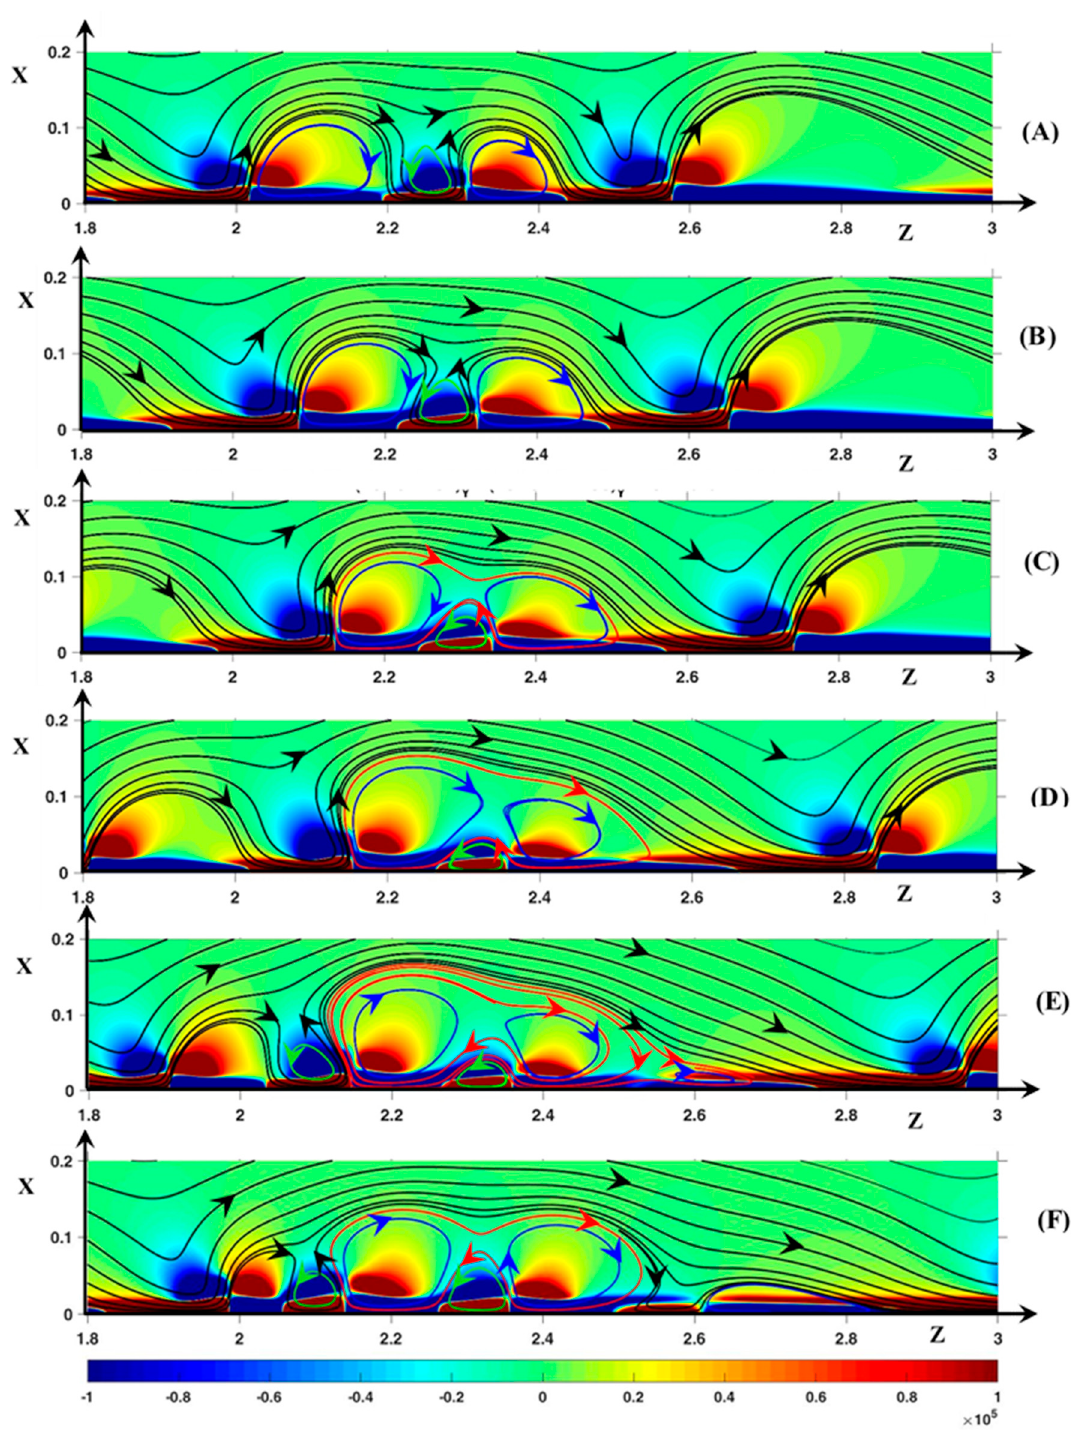
Figure 9. Temporal evolution of the cluster structure. ( A ) t ’ = 0; ( B ) t ’ = 20; ( C ) t ’ =40; ( D ) t ’ = 60: ( E ) t ’ = 80; ( F ) t ’ = 100. Color plot: ( ) Tot z F . Black lines: static streamlines starting from the inlet. Blue streamlines: clockwise rotating rolls, green streamlines: counter-clockwise rotating rolls, red streamlines: cluster envelope. ∆Φ = 27, ν = 1/3 × 10 − 3 , D ± = 1 .